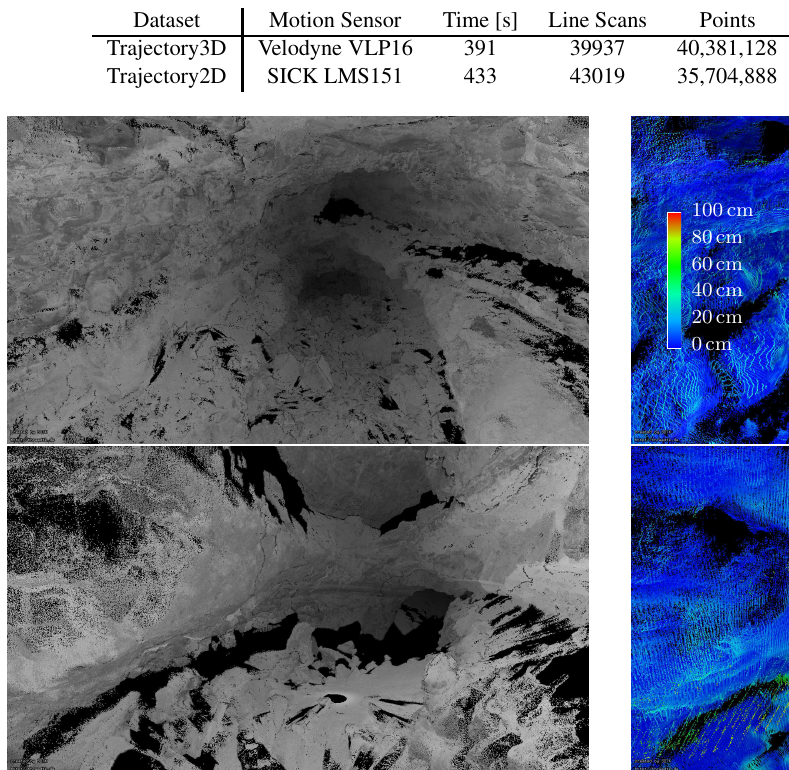
Table 1. Information on the datasets presented